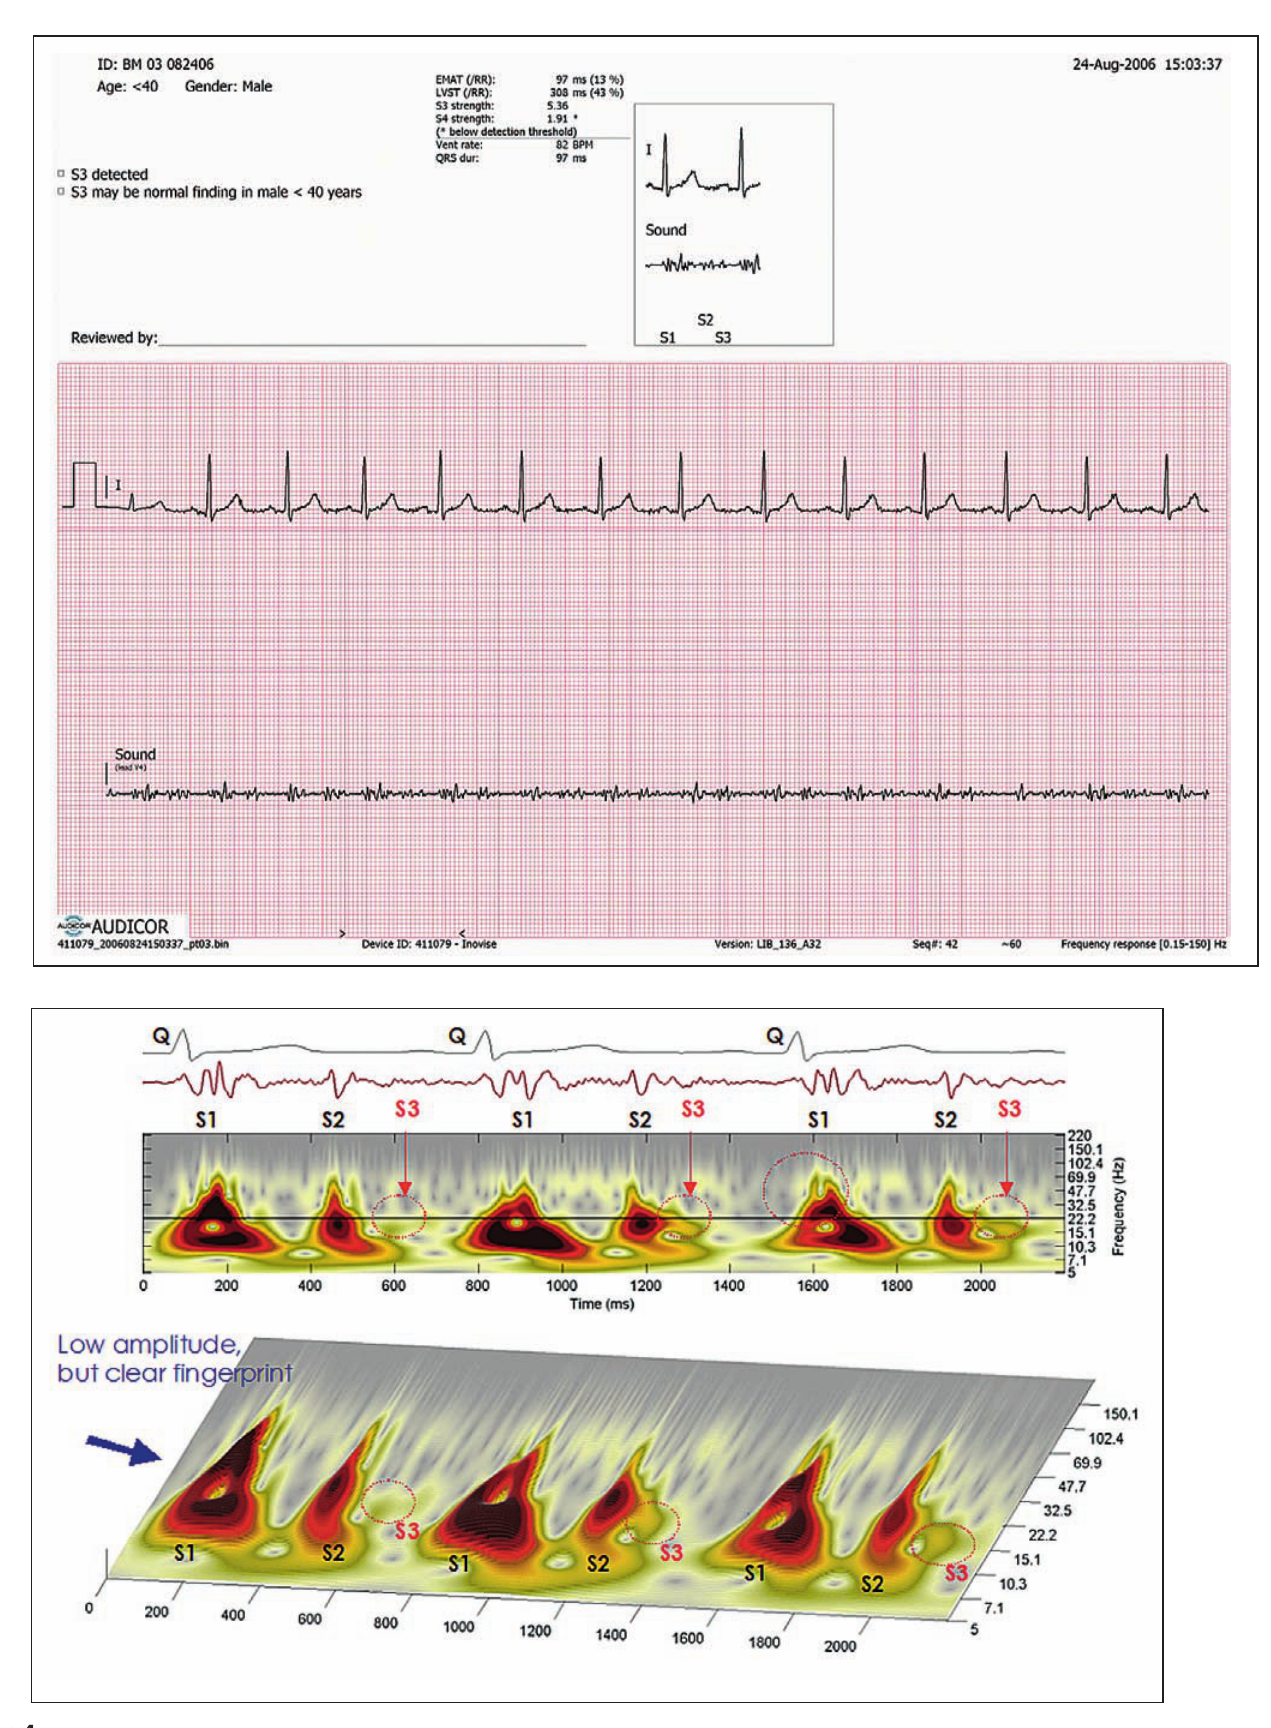
Figure 4 Acoustic cardiography report and time-frequency analysis of heart sounds for a subject with high body mass. The upper panel (a) shows an acoustic cardiography report for a subject with high body mass (male, 560 pounds), and the panels below illustrate the 2D (b) and 3D (c) scalogram view for three beats of the same recoding as in the upper figure. While the intensity of the heart sounds is drastically lower than in subjects with normal weight, the “fingerprint” for each heart sound is the same as in normal weighted subjects, and therefore, allows an accu- rate analysis of the heart sounds by acoustic cardio